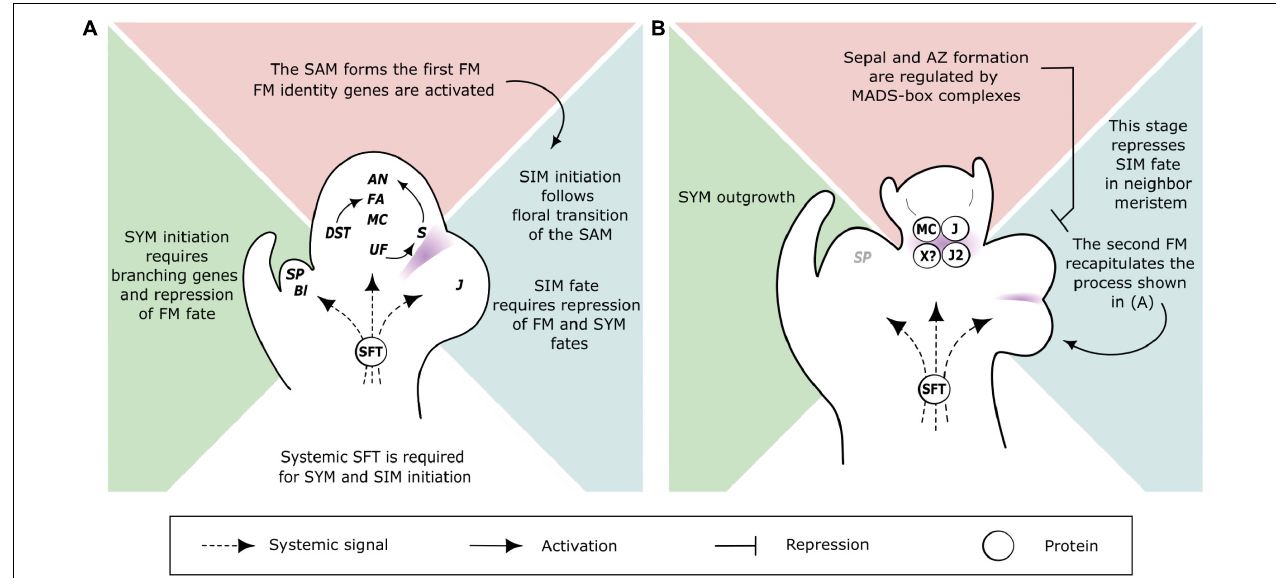
FIGURE 2 | Proposed models of genetic and spatiotemporal regulation of meristem fate and branching in the inflorescence of tomato. (A) Triptych of meristems developing side-by-side at the start of inflorescence branching (stage 3 of Figure 1A ). Central panel (pink): the SAM. A set of genes are activated early during floral transition of the SAM, including UF , S , and the FM identity genes MC , FA and AN . Arrows show known activation cascades. Right panel (blue): the SIM. A lateral SIM emerges after the floral transition of the SAM and requires transient repression of FM and SYM fates. The J gene is involved in this transient state. Left panel (green): the SYM. The branching gene Bl is required for SYM initiation and the vegetative phase of the SYM is due to the expression of SP , which antagonizes florigen SFT. The systemic SFT protein is required for floral transition of the SAM, initiation of the SIM and sympodial growth of the shoot continued by the SYM. (B) Critical stage in flower development regulating inflorescence branching (stage 4 of Figure 1A ). Central panel (pink): the first FM. The initiation of sepals and pedicel abscission zone is regulated by MADS-box proteins, including MC, J, J2, and a putative target of SFT (X?), which are represented as a simplified and hypothetical tetramer complex. At that stage, the FM is a non-permissive environment for initiation of a lateral SIM on its flank. Right panel (blue): the first SIM has formed the second FM and the second SIM. These meristems recapitulate the processes shown in A ). Left panel (green): SYM outgrowth correlates with downregulation of SP , which allows floral transition of the sympodial shoot segment. Gene/protein abbreviations: AN , ANANTHA ; Bl , BLIND ; DST , DELAYED SYMPODIAL TRANSITION ; FA , FALSIFLORA ; J , JOINTLESS ; J2 , JOINTLESS2 ; MC , MACROCALYX ; S , COMPOUND INFLORESCENCE ; SFT , SINGLE FLOWER TRUSS ; SP , SELF PRUNING ; UF , UNIFLORA. Meristem annotations: FM, flower meristem; SAM, shoot apical meristem; SIM, sympodial inflorescence meristem; SYM, sympodial shoot meristem. In (A,B) purple areas indicate expression domains of boundary